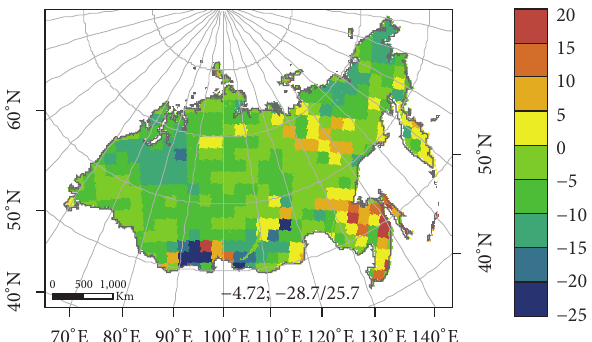
Figure 4: The spatial distribution of the (%) variations in snow days from 1970 to 2013. The spatially averaged (%) variations along with the minimum/maximum (%) variations over the study area are also shown.